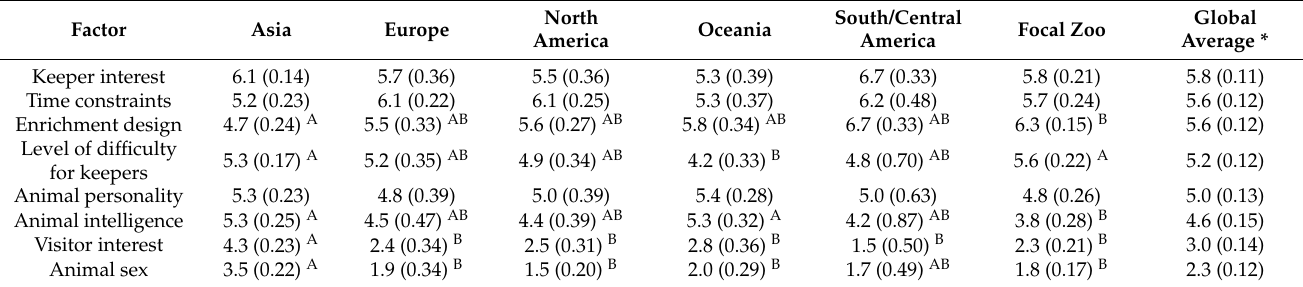
North South/Central Global Oceania Focal Zoo America America Average *